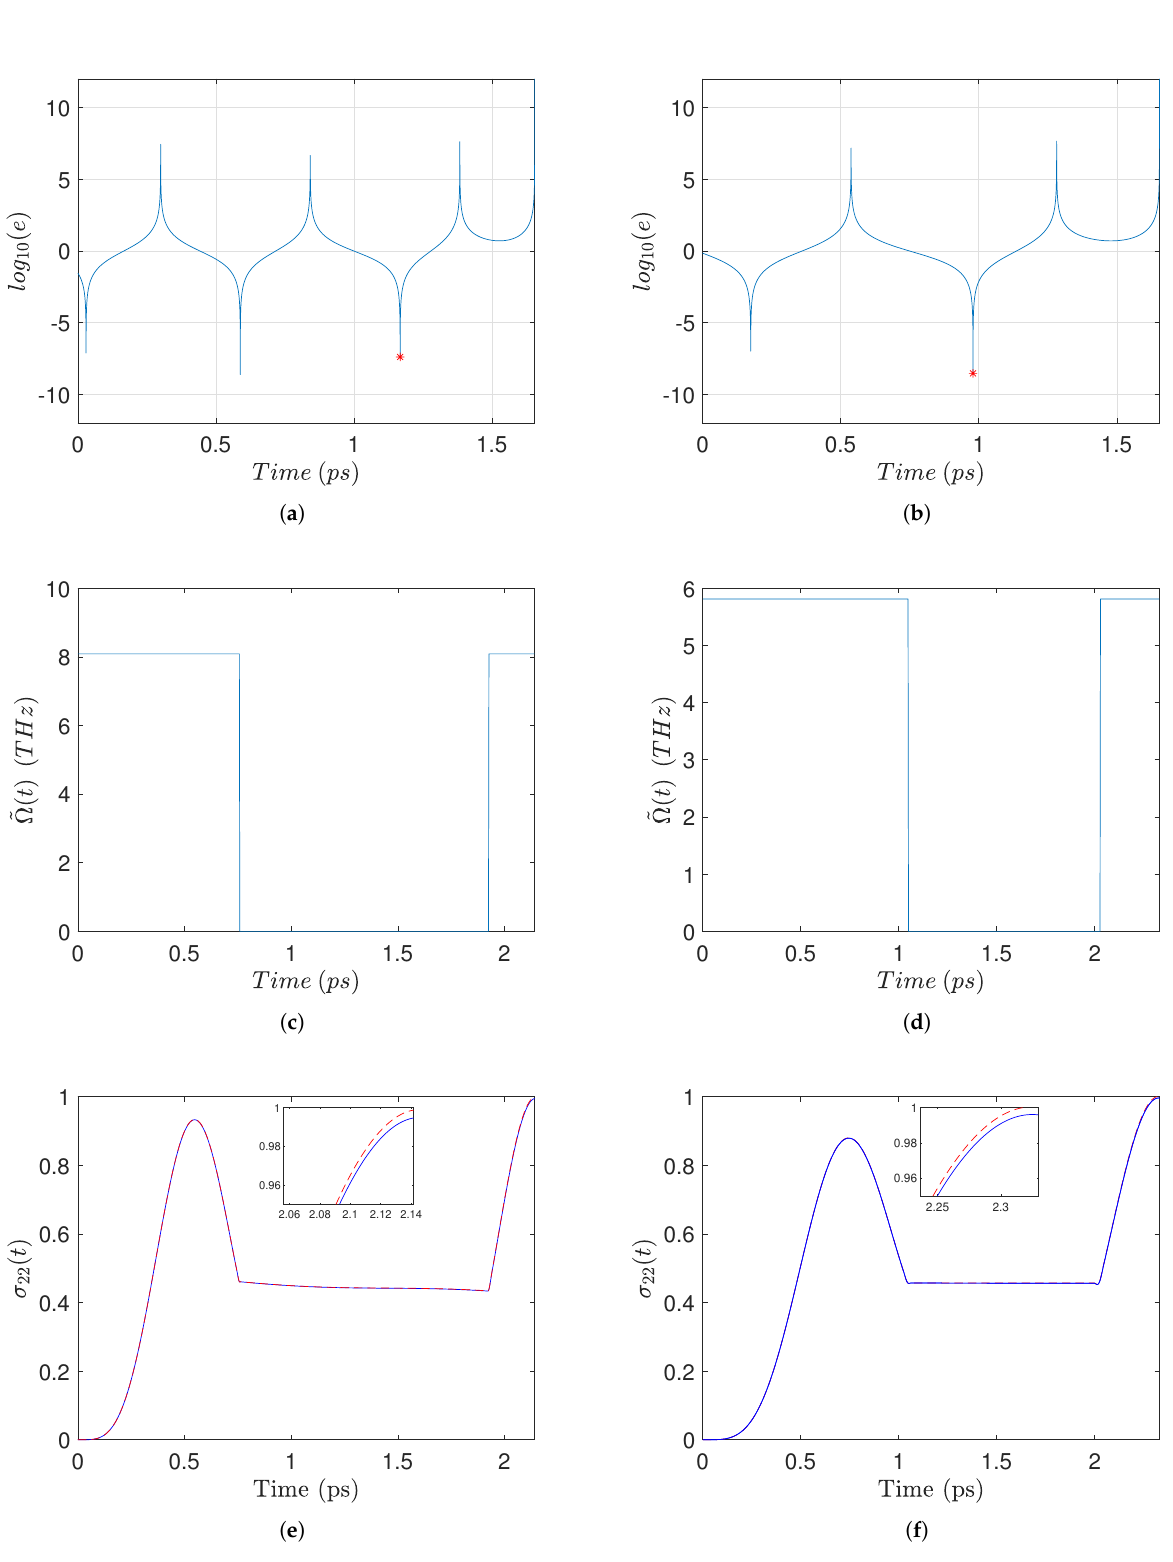
Figure 3. Left-column top to bottom: ( a ) Logarithmic squared error (28), ( c ) pulse-sequence, and ( e ) time evolution of σ 22 ( t ) , for R = 13 nm and E B = 2.5 meV. In the right-column ( b , d , f ) we display similar plots for the case with a larger interparticle distance R = 30 nm but the same biexciton energy shift E B = 2.5